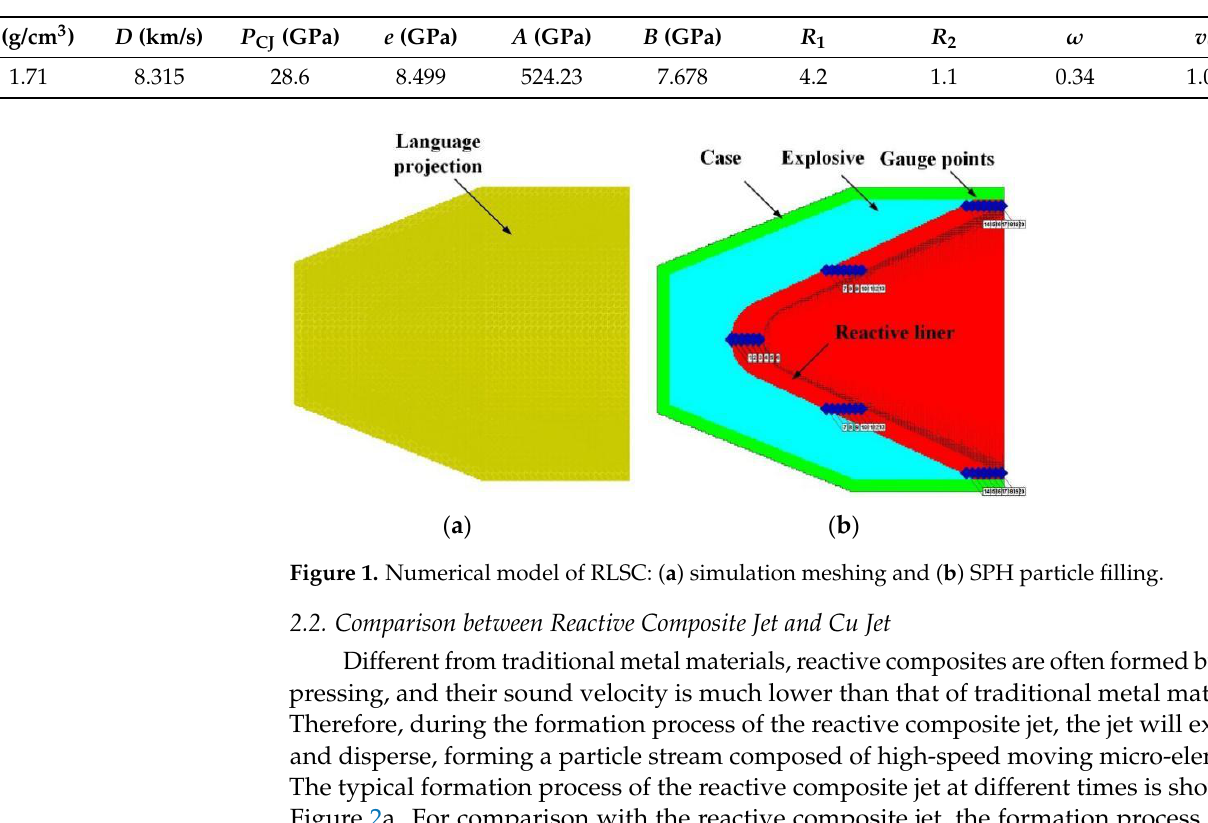
( b ) Figure 3. Reactive composite jet formation process ( a ) static coordinate system ( b ) and dynamic coordinate system. The element on the wall of the reactive liner moves towards the axis with the pressing velocity v 1 . When it reaches the axis collision point A, it is divided into the reactive com- posite jet and slug. The jet moves at a velocity v j , and the slug moves at a velocity v s , where β is the collapse angle of the element of the liner. The moving coordinate system is estab- lished with the collision point A (velocity v 2 ) as the stagnation point, and then the process of the element of the liner colliding to form the jet and slug can be described as steady flow. According to the Bernoulli equation, the wall element of the reactive liner in the moving coordinate system flows to the collision point at a velocity v 3 , and still flows to the jet and slug at a velocity v 3 . When v 3 is greater than the material sound velocity C 0 and the supersonic collision forms an attached shock wave β c greater than β , the jet will not con- dense. Different from traditional metal materials, since fluoropolymer-based reactive composites are often formed by cold pressing and have certain pores inside them, the sound velocity of the material is much lower than that of traditional metal materials (lower than 2000 m/s) [24]. Therefore, the reactive composite jet will diverge during the formation process and will diverge into many small particles in the radial direction.